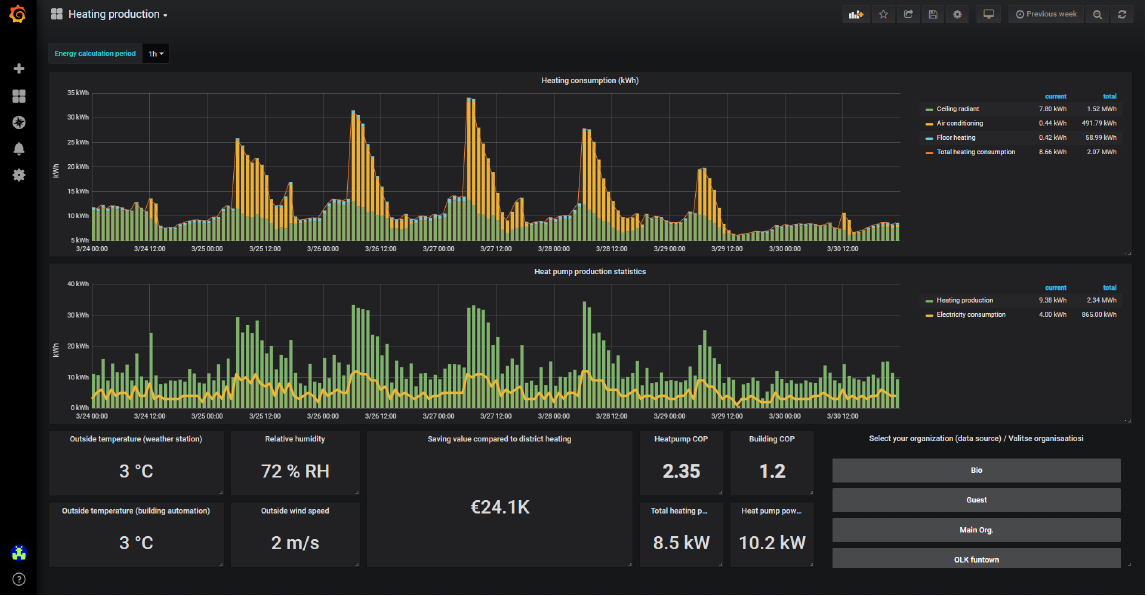
Figure 7: Example of Grafana